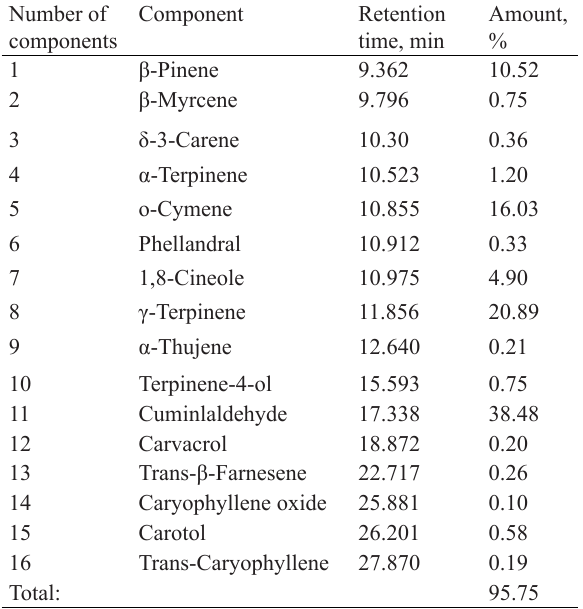
Table 2 Composition of cumin essential oil Table 3 Experimental design of burgers with thyme and